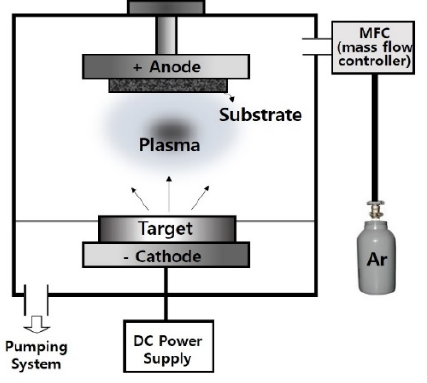
Figure 2. Schematic diagram of the direct current (DC) sputtering system used to produce Ag-coated Figure 2. Schematicdiagramofthedirectcurrent(DC)sputteringsystemusedtoproduceAg-coatedc-NFs. c-NFs. Table 2. Experimental conditions for producing Ag-coated carbon-based nonwoven fabrics (c-NFs) using a direct current (DC) sputtering